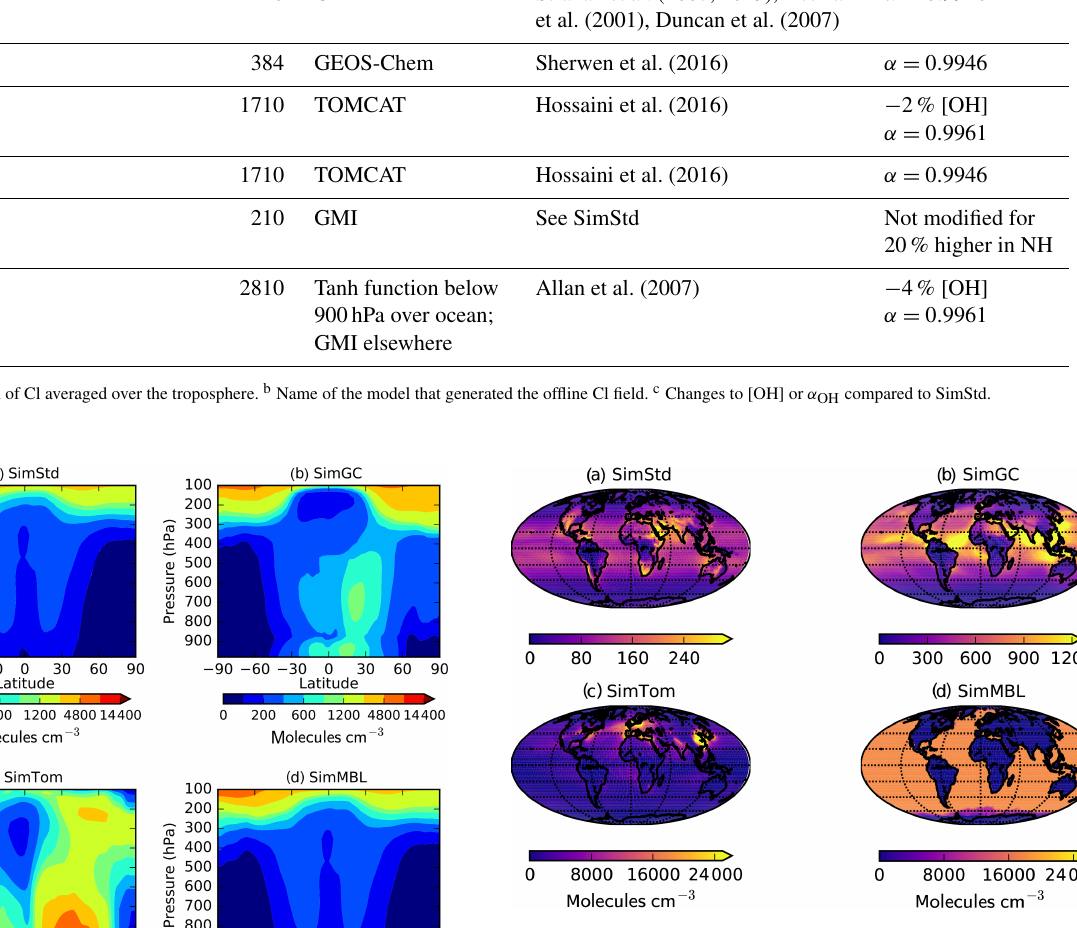
Figure 3. Annual mean surface concentrations of Cl in (a) SimStd, (b) SimGC, (c) SimTom, and (d) SimMBL. Note the different color scales between